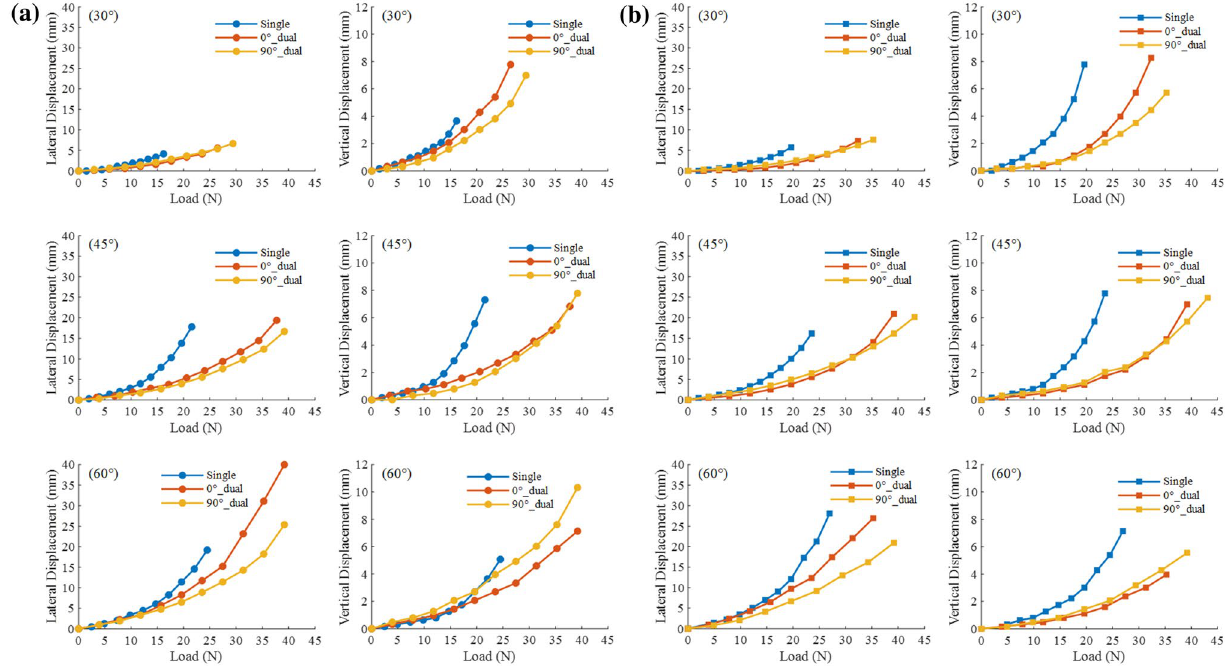
Figure 9. Lateral and vertical displacement-load cures of circular ( a ) and square ( b ) anchor piles with variables